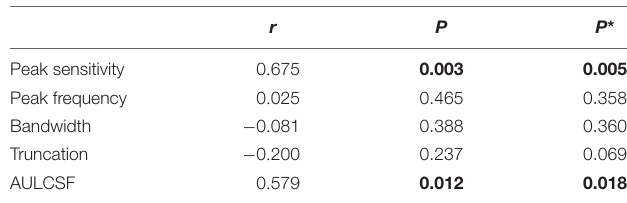
TABLE 2 | The correlation between the post alteration CSF parameters from baseline and the refractive error in the experimental group.